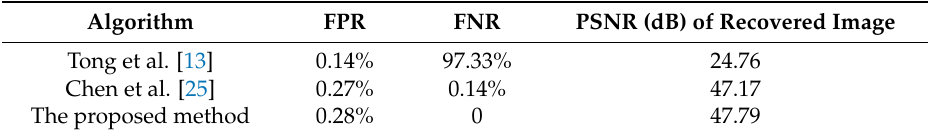
Figure 8. Tamper detection and recovery performance for collage attack: ( a ) Watermarked Car1 image; ( b ) watermarked Car2 image; ( c ) attacked image; ( d ) tamper detection result using the method in [13]; ( e ) tamper detection result using the method in [25]; ( f ) tamper detection result of the proposed method; ( g ) image recovery result using the method in [13]; ( h ) image recovery result using the method in [25]; ( i ) image recovery result of the proposed method. Table 5. Performance comparisons for collage attack using Car1 and Car2